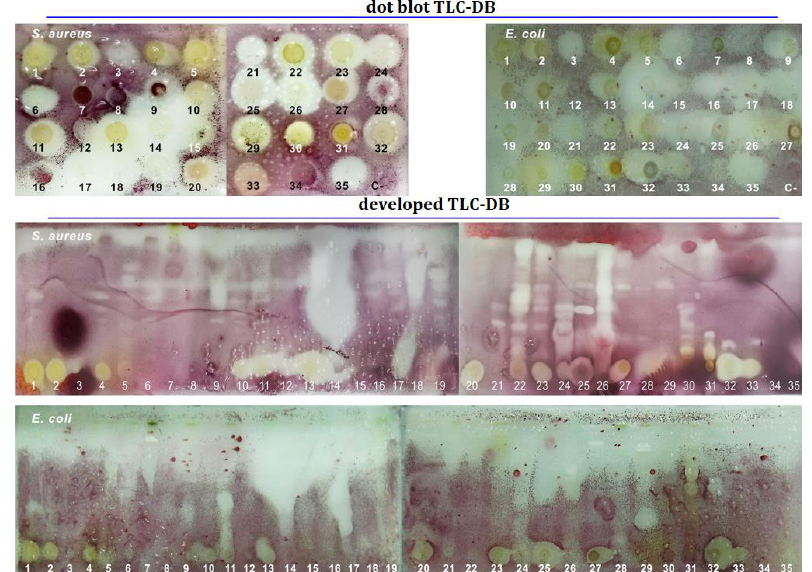
Figure 3. Qualitative antibacterial activity evaluation of Halmahera plant extracts using TLC direct bioautography (TLC-DB) against S. aureus and E. coli . Dichloromethane-methanol with a ratio of 10:1 was used as the mobile phase for developed TLC-DB. The list of Halmahera plant extracts (number 1-35) (Table